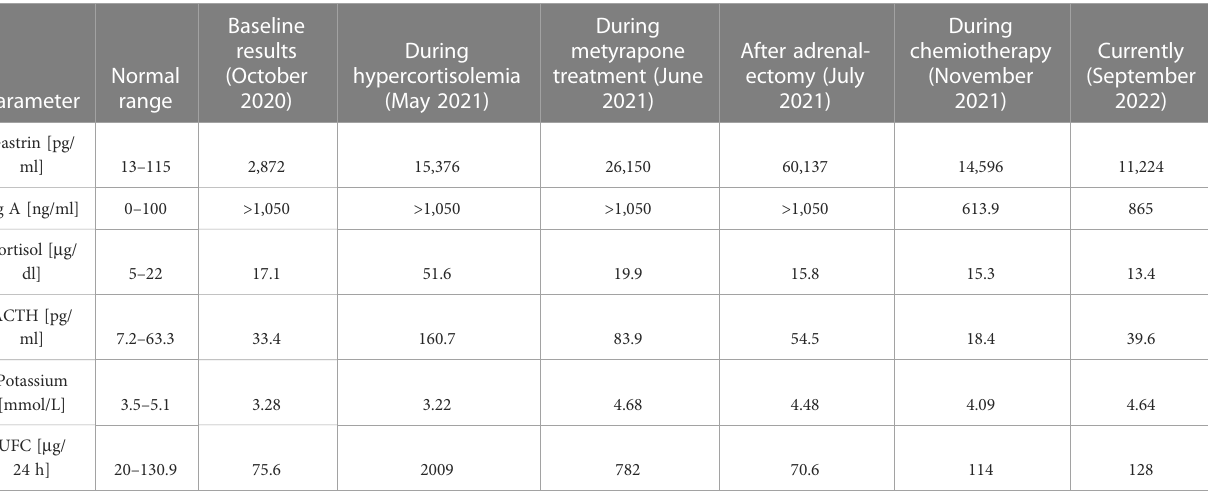
TABLE 1 Laboratory results presented in chronological order.